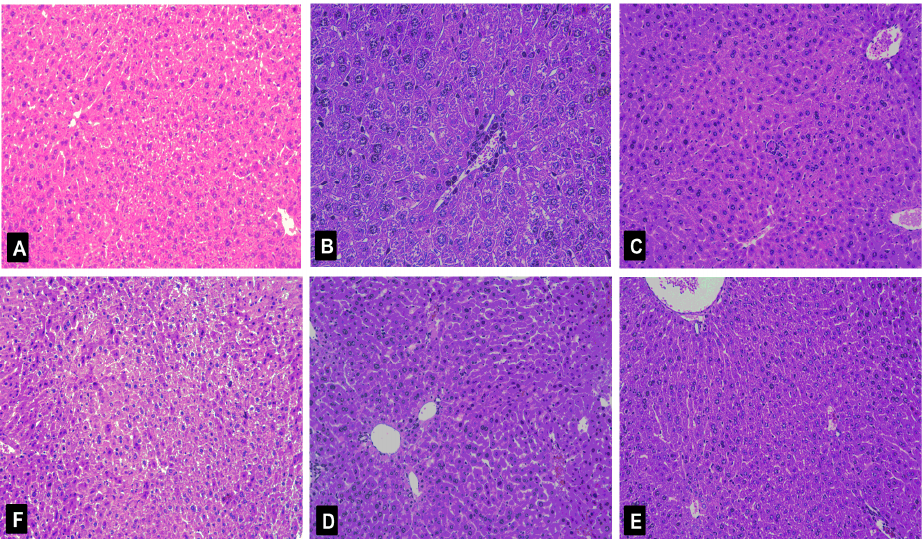
Figure 7. Histological analysis of the livers after D -GalN administration. Typical images were chosen from the different experimental groups (original magnification 10 × 20). ( A ) Control group; ( B ) D -GalN-treated group; ( C ) D -GalN and DDB (150 mg/kg bw)-treated group; ( D ) D -GalN and nicotiflorin (25 mg/kg bw)-treated group; ( E ) D -GalN and nicotiflorin (50 mg/kg bw)-treated group; and ( F ) D -GalN and nicotiflorin (100 mg/kg bw)-treated group.